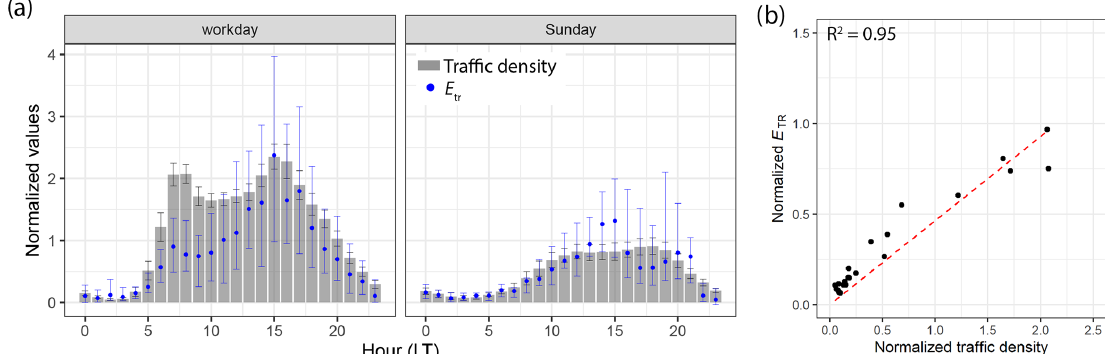
Figure 12. Comparison between diurnal profiles of traffic density and modelled E TR in Ljubljana. Normalized mean hourly values are presented for traffic density, whereas E TR values are presented in terms of normalized median and 25th and 75th quantiles (a) . Linear regression (without offset) of points from 00:00 to 10:00 that are presented in the diurnal plot results in R 2 = 0 .